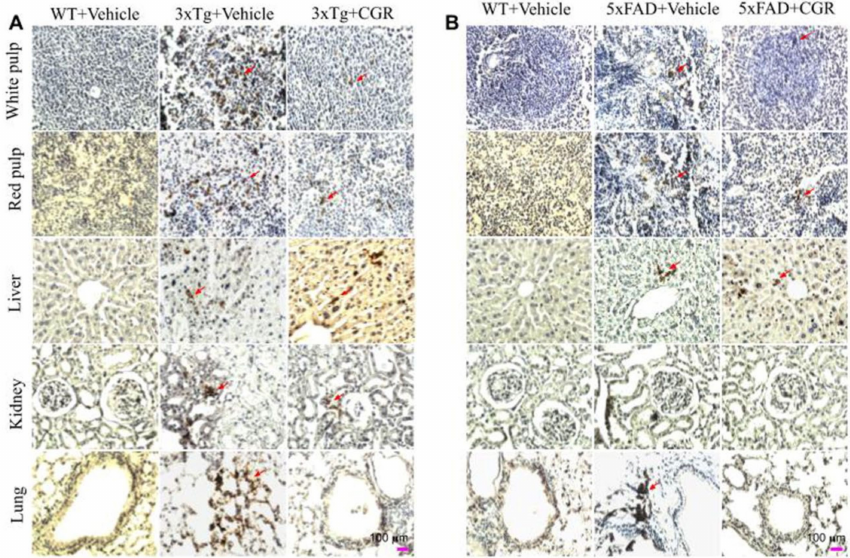
Figure 12. Cleaved caspase-3 immunoreactivity in the peripheral organs of 3xTg and 5xFAD mice after treatment with CGR. After paraformaldehyde fixation and paraffin-embedding, the spleen, liver, kidney and lung tissues from the WT, 3xTg (24-month-old) and 5xFAD (18-month-old) and their respective CGR-treated mice were immunolabeled with cleaved caspase-3 using avidin-biotin complex (ABC) method and the color was developed with diaminobenzedine (DAB). The images were taken by a compound light microscope using 40 × objectives (total magnification = 40 × ). ( A , B ) Representative photomicrographs of the spleen, liver, kidney and lungs from 24-month-old 3xTg mice ( A ) and 18-month 5xFAD mice ( B ) after treatment with CGR. Note that the 3xTg and 5xFAD mice significantly increased the number of cleaved caspase-3 immunoreactivity (arrows) in all these tissues; the CGR treatment prevented these levels. Scale bar = 100 µ m and is applicable to all other images.